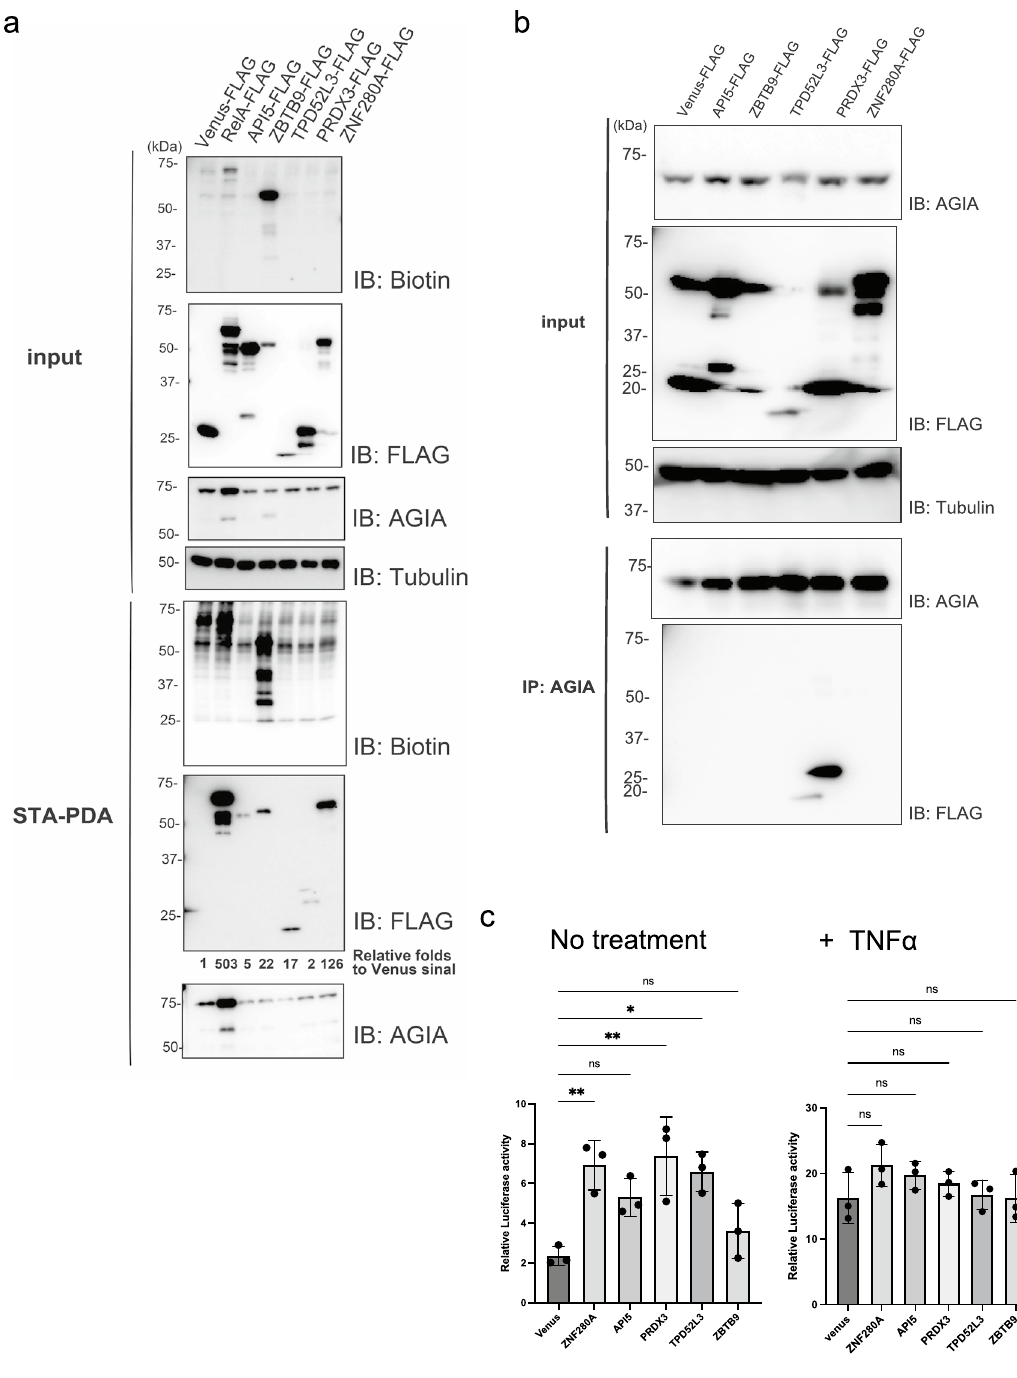
Figure 5. Validation of IκBα-interacting proteins in cells. ( a ) Streptavidin pull-down assay. The Venus gene, as a control, and each selected gene in pCAGGS-MCS-FLAG were transfected in HEK293T cells stably expressing AGIA-AirID-IκBα. After transfection for 24 h, d-biotin was added to 50 µM culture medium for 2 h. Then, the biotinylated proteins were pulled down using streptavidin beads and analysed by immunoblotting. ( b ) Co-immunoprecipitation. HEK293T cells stably expressing AGIA-AirID-IκBα were transfected with each selected gene in pCAGGS-MCS-FLAG. The control experiment used a transfected Venus gene. Immunoprecipitation was performed using anti-AGIA antibody. Immunoprecipitated proteins were detected with anti-FLAG and anti-AGIA antibodies. ( c ) Analysis of NF-κB activity by overexpression of each selected gene under basal conditions. HEK293T cells were transfected with each selected gene along with a luciferase reporter containing the NF-κB promoter, and then the cells were treated with DMSO (No treatment) or TNFα (+ TNFα) for 1 h. Data from each luciferase assay shown are derived from three independent experiments. Error bars denote the standard deviation (independent experiments: n = 3) and the P -values were calculated by one- way ANOVA with Tukey’s post-hoc test (** P = 0.002). Source data are provided as a Source data